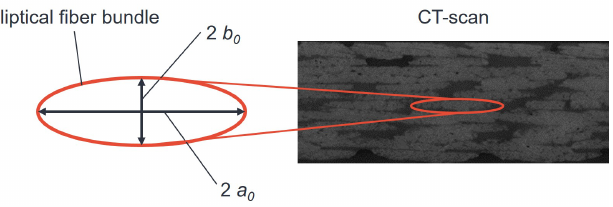
Figure 8. Determination of the equivalent radius of the fiber bundles r eq by computed tomography studies of the cross